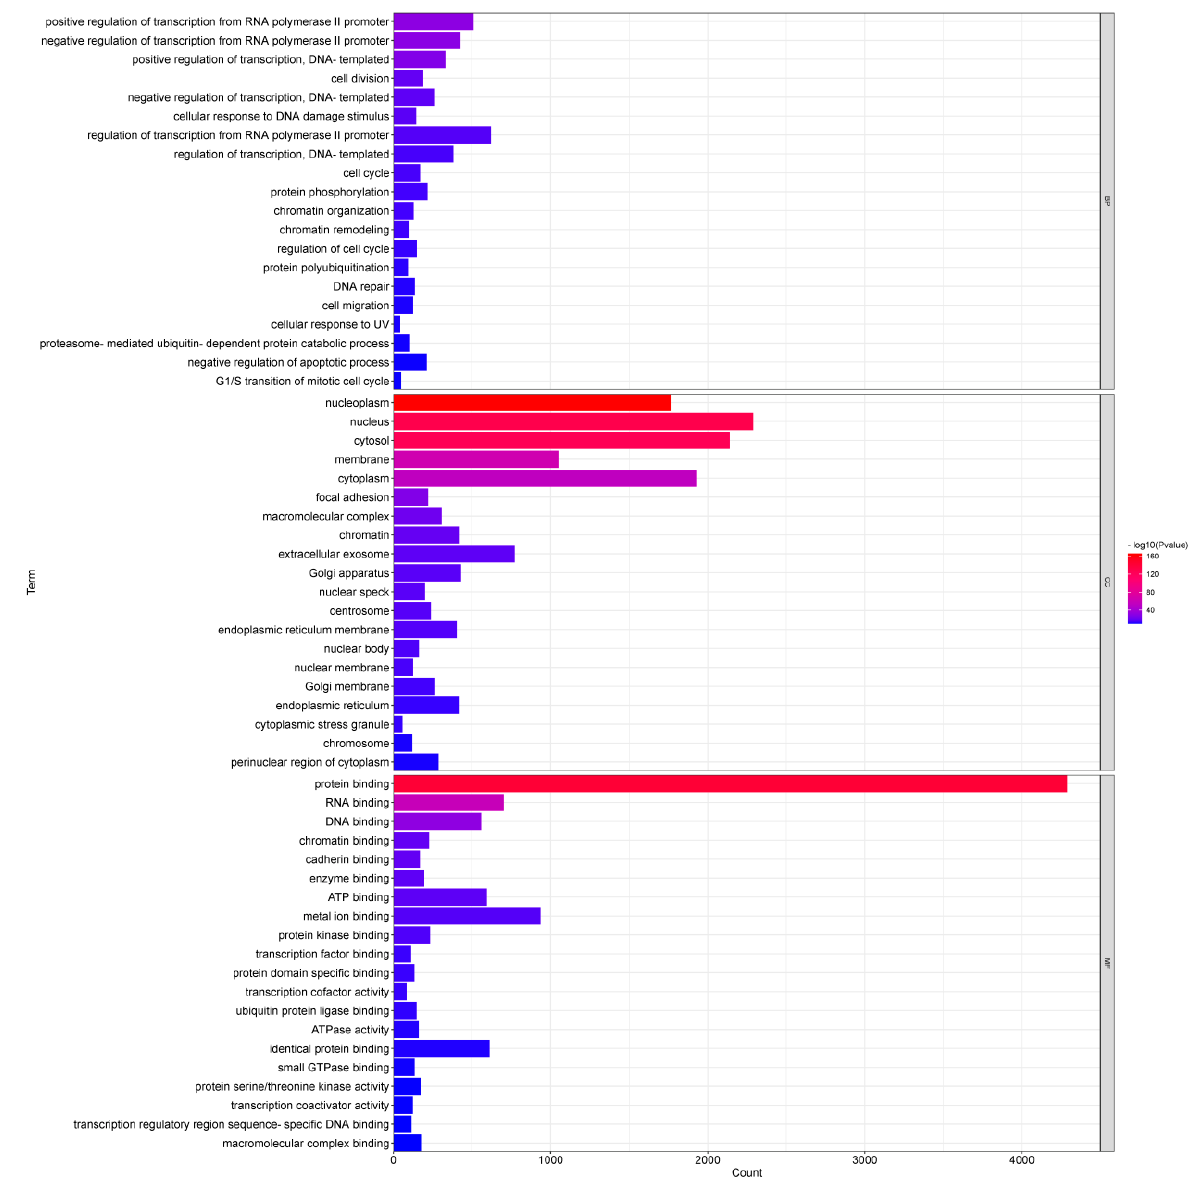
Figure 5. GO enrichment analysis of target genes of DEMs.